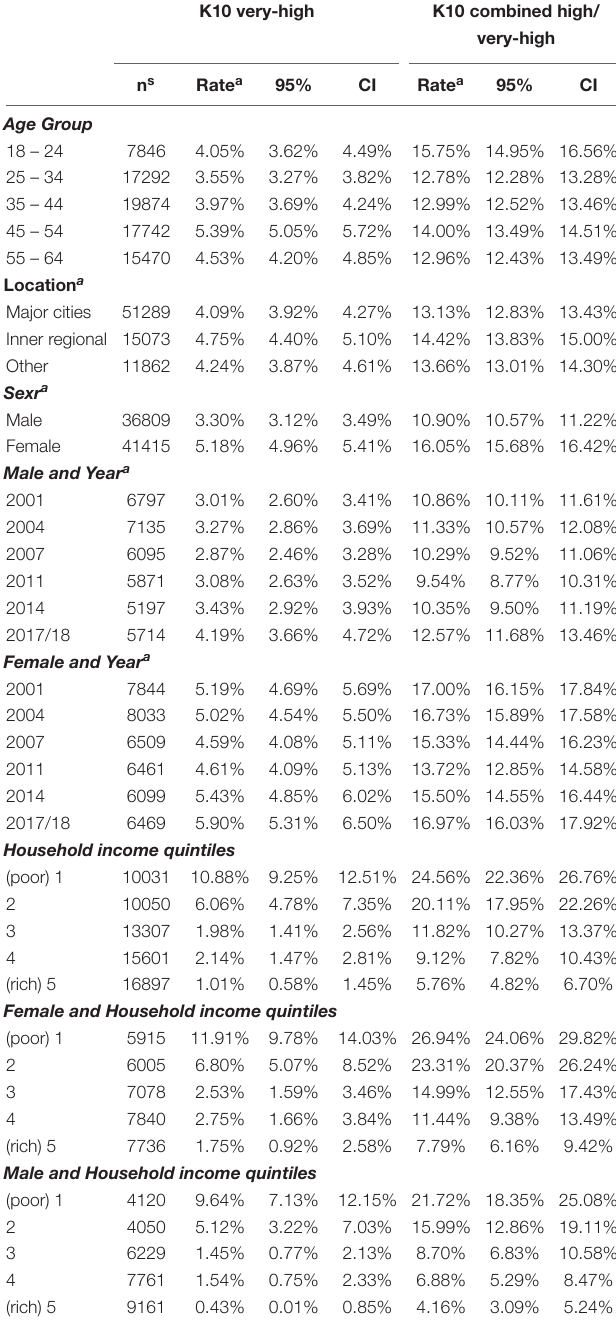
TABLE 1 | Age-standardized prevalence of psychological distress in the Australian working age population,